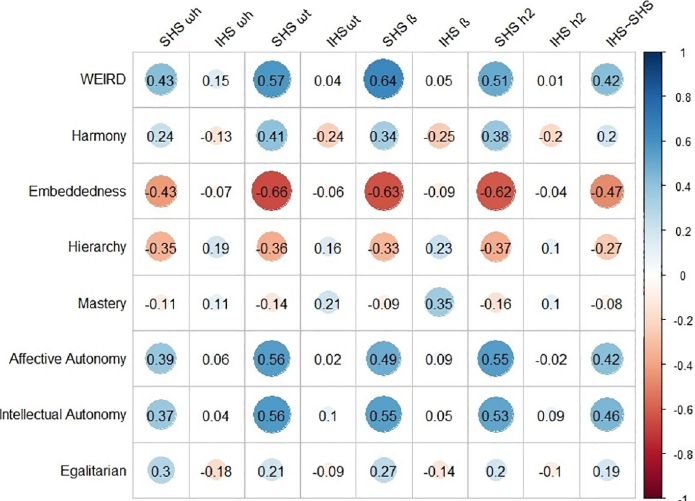
Fig 3. Country level correlations between subjective country level variables and happiness variable